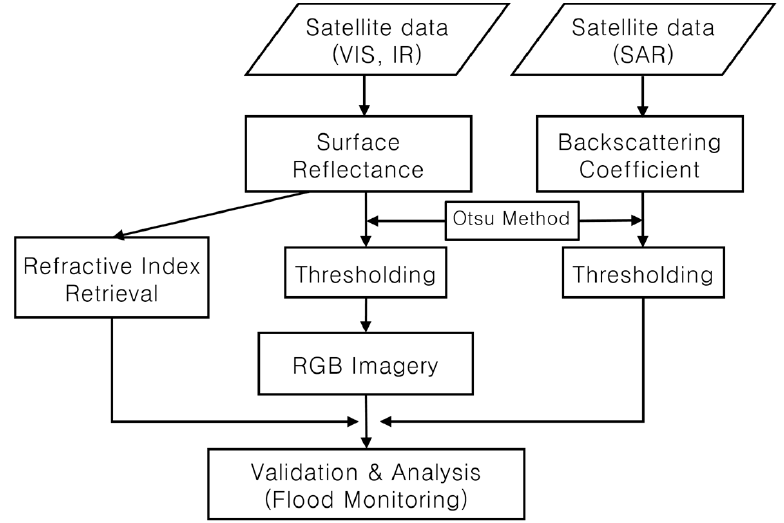
Figure 5. An outline of the research procedure.